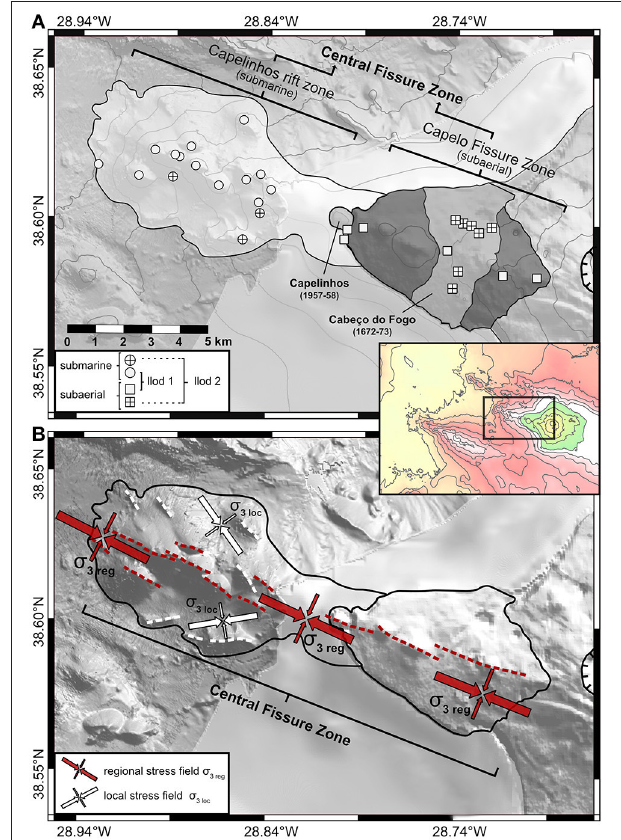
FIGURE 6 | Bathymetric map and DEM of the Central Fissure Zone comprising of a submarine part (Capelinhos rift) and a subaerial part (Capelo Fissure Zone). In (A) different smaller volcanic units are shown and refer to historic eruptions along the Central Fissure Zone. Numbers in brackets are year of eruption (A.D.). Symbols are the same as in Figure 4 and refer to two liquid lines of descent with lower (llod 1) and higher (llod 2) K 2 O contents. (B) Schematic model of the local and regional stress fields during the formation of the Central Fissure Zone. Red dashed lines and arrows display the orientation of lineaments reflecting the regional stress field ( σ 3reg perpendicular to the WNW-ESE lineaments); white dashed lines and arrows display the orientation of the local stress field ( σ 3loc perpendicular to NW-SE and WSW-ENE lineaments). Inset map for orientation.